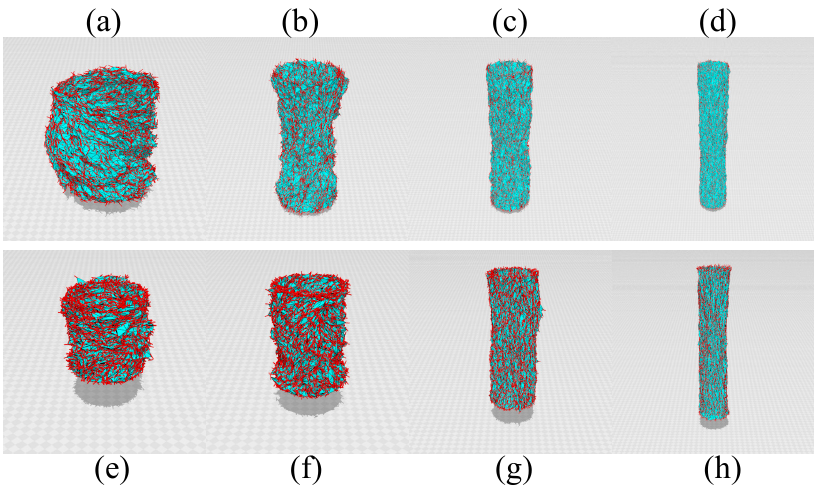
Figure 11. Snapshots of cylindrical surfaces of the 2D model ( a – d ) and 3D model ( e – h ) corresponding to the simulation data in Figure 9a. The heights of surfaces are ( a ) H (= D 0 ) = 14, ( b ) H = 32, ( c ) H = 52, and ( d ) H = 78 for the 2D model and ( e ) H (= D 0 ) = 8.3, ( f ) H = 12, ( g ) H = 24, ( h ) H = 40 for the 3D model. The scales of the figures are di ff erent from each other. The (red) burs on the surface represent the variable σ